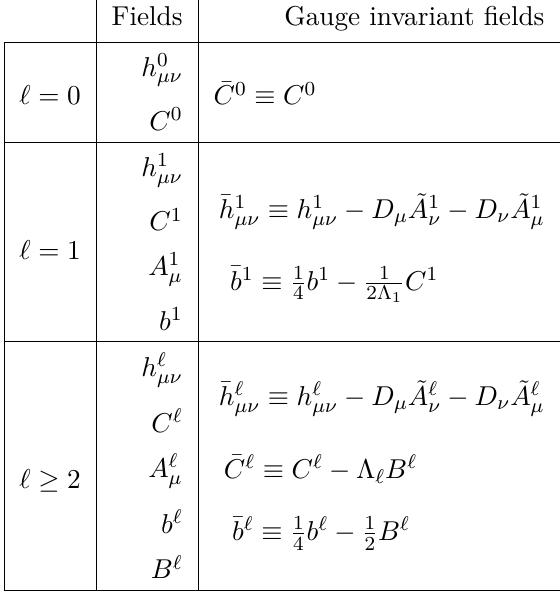
is a deformation of the AdS part of the background metric (since it µν ≡ A 1 − D µ C 1 / (2Λ 1 ) , such that δ µ µ ˜ = ξ ‘ A ‘ µ µ